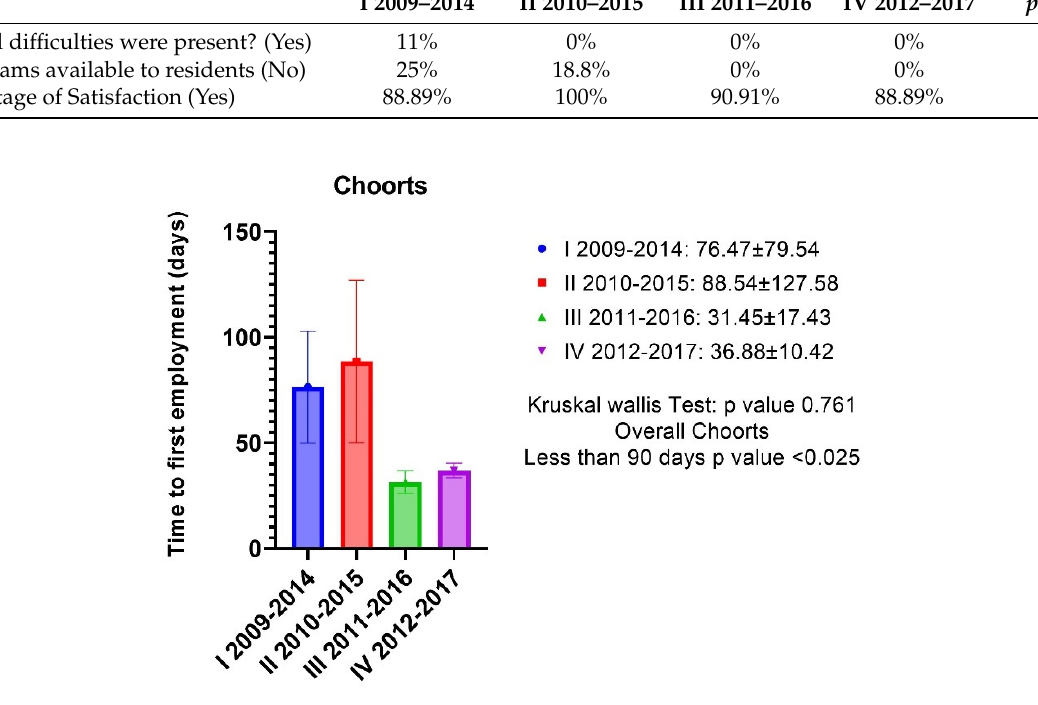
Figure 1. There were no differences in terms of time-to-first-job based on the cohorts. The mean time-to-first-job was under 90 days and specifically 60.28 ± 79.73 (sd), CI (34.43–86.12) with a p -value of 0.025.